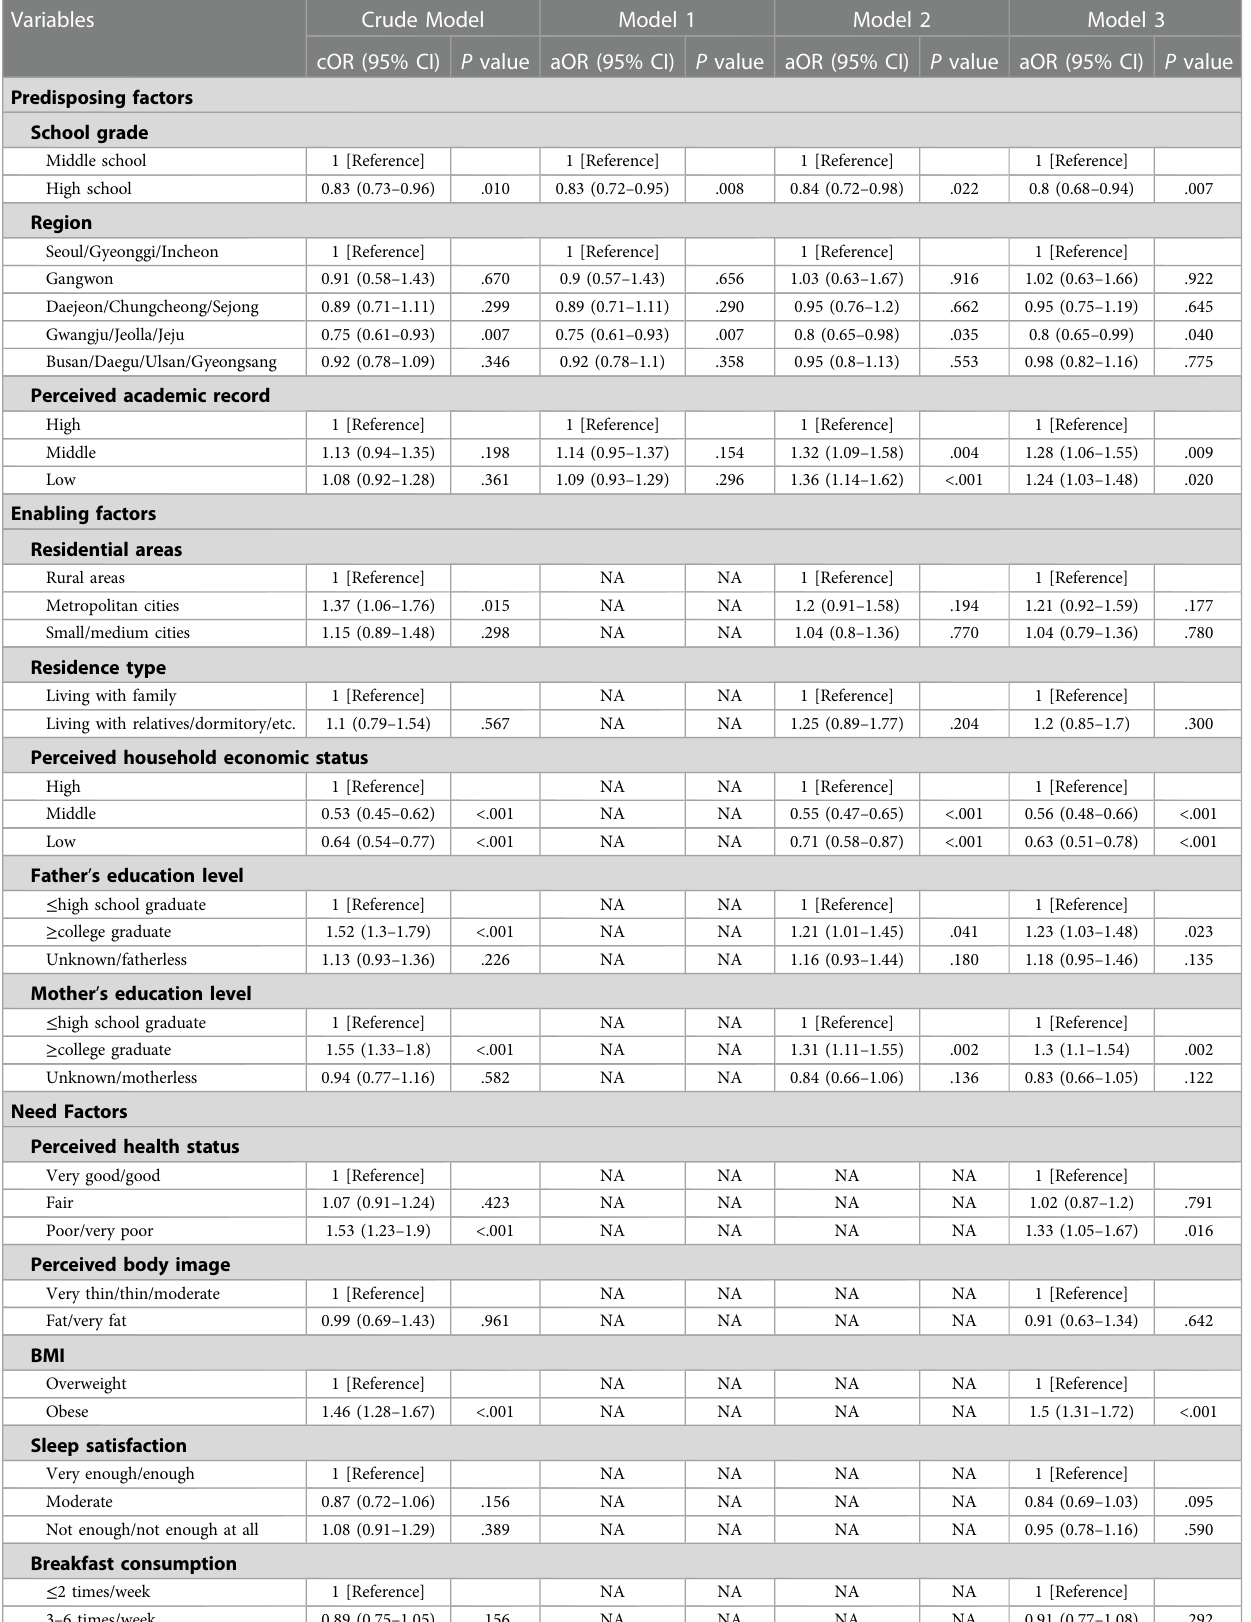
TABLE 3 Association of herbal medicine use with predisposing, enabling, and need factors in female students.